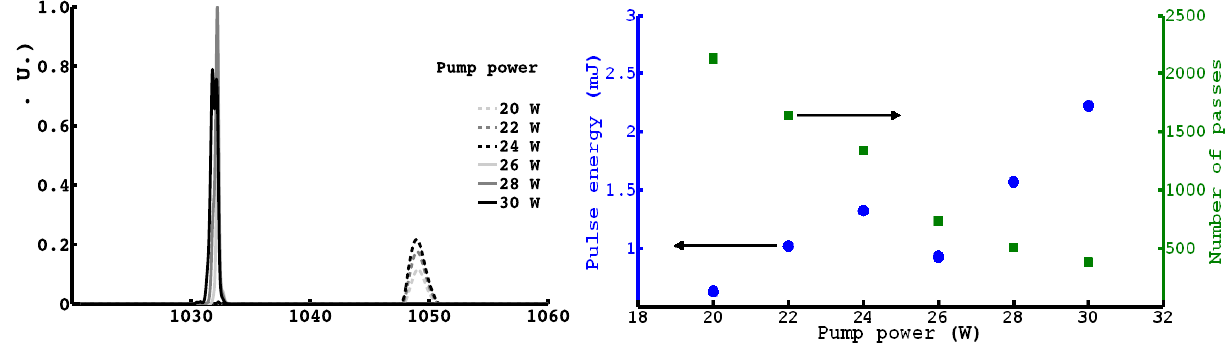
Figure 3. Simulation of free-running cavity based in Yb:YAG. Left : Output intensity vs . wavelength for a range of pump power; Right : output energy and required number of passes vs . pump power.